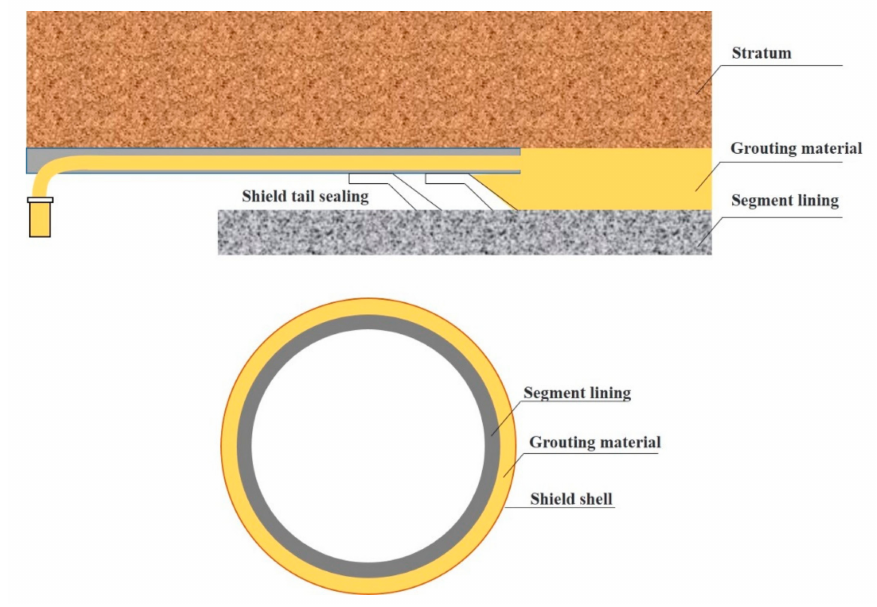
Figure 1. Synchronous grouting in shield